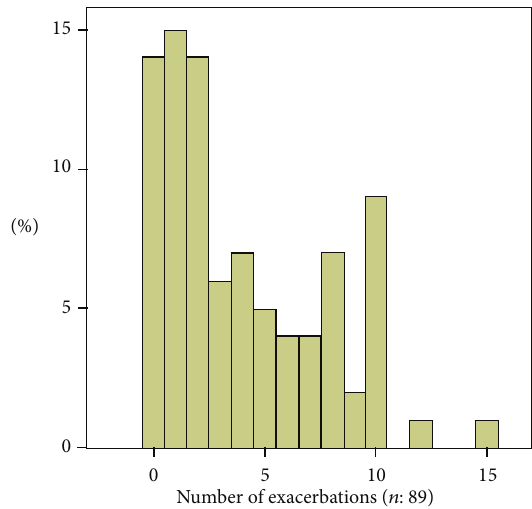
Figure 2: Histogram showing distribution of exacerbations.